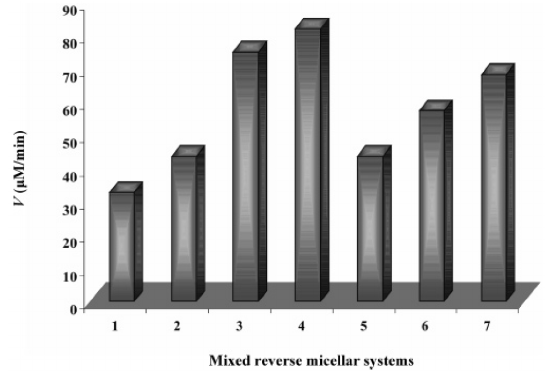
Figure 1. Dependence of horseradish peroxidase (HRP) activity on the composition of mixed reverse micelles at z = 8, 25 °C, pH = 7 (25 mM phosphate buffer). [HRP] = 1 μ g/mL, [Pyrogallol] = 0.3